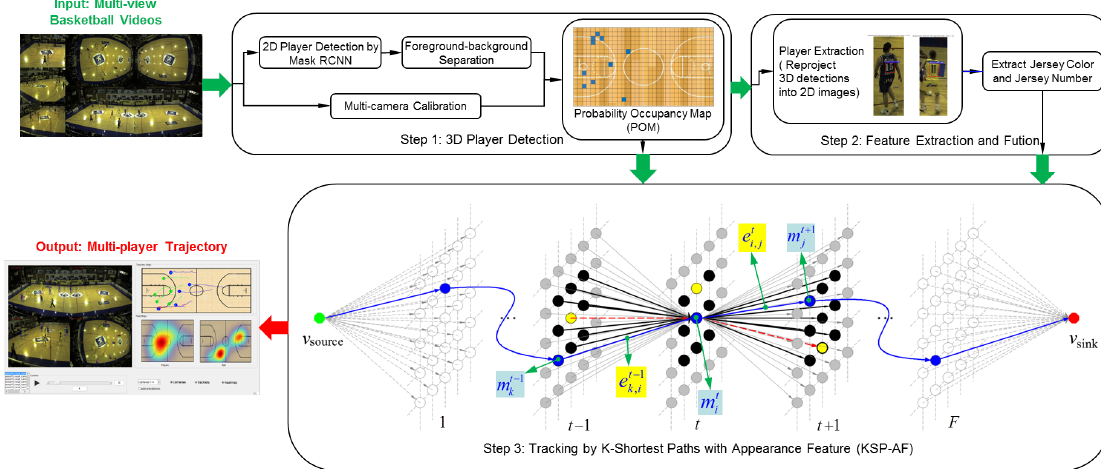
Figure 2. The pipline of the multiple-player tracking system based on the KSP-AF tracking method mainly consists of three parts: (1) 3D player detection [42], (2) feature extraction, and (3) tracking by k-shortest paths with appearance feature (KSP-AF). The input of the whole system is multi-view basketball videos, and the output is multiple player trajectories. For the KSP-AF tracking, the inputs are both of the 3D detections represented as POM data and the extracted features for each